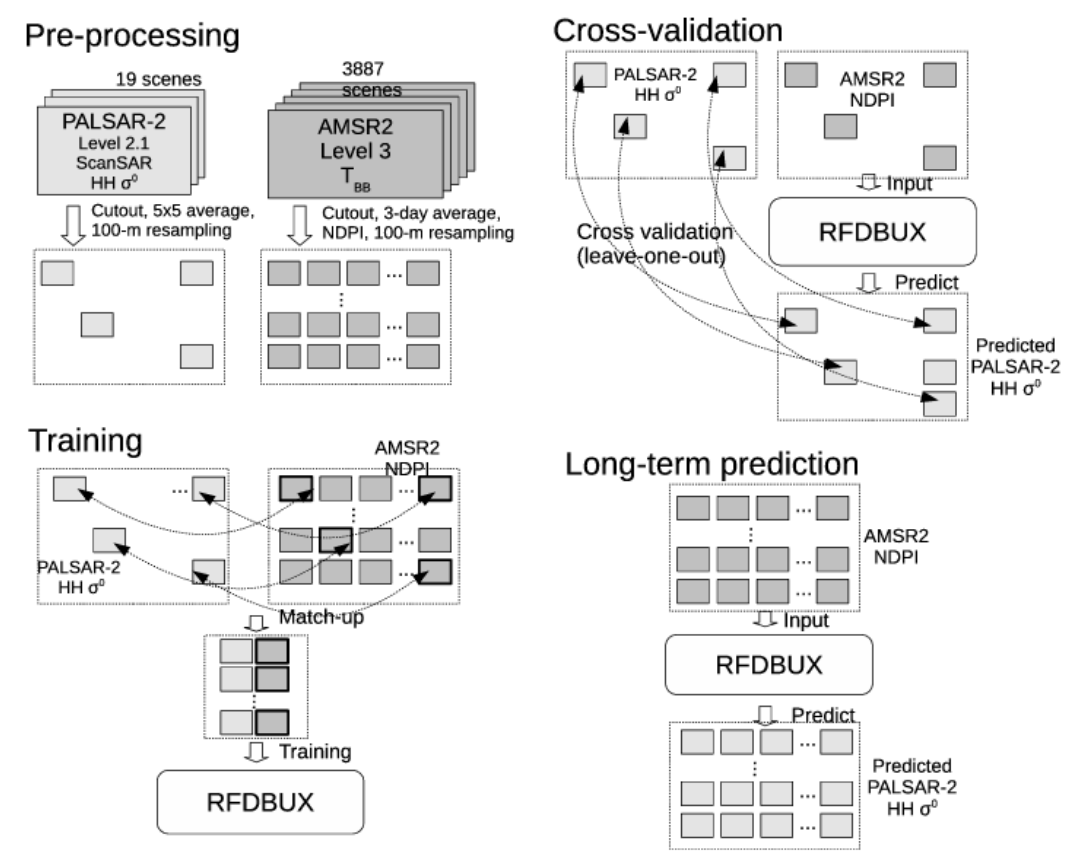
Figure 1. Schematic flowchart of the analysis procedure. HH— horizontal transmitting and horizontal receiving; AMSR2—Advanced Microwave Scanning Radiometer 2; NDPI—normalized difference polarization index; SAR—synthetic aperture radar; PALSAR—phased array type L-band SAR.